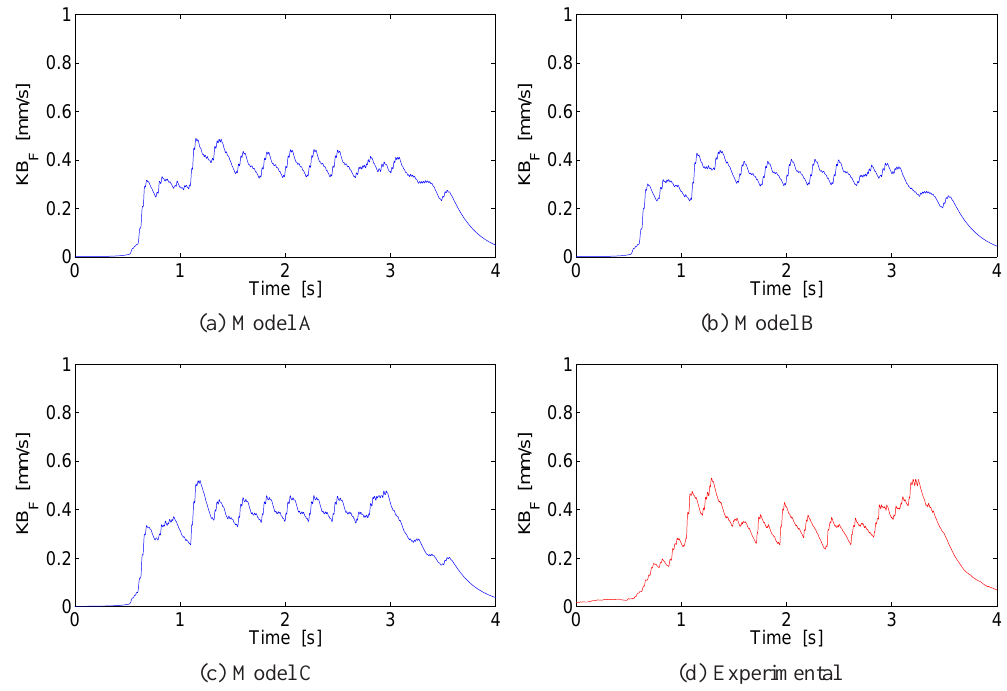
Figure 16. Predicted and measured weighted severity of vertical ground velocity at 9m from the track